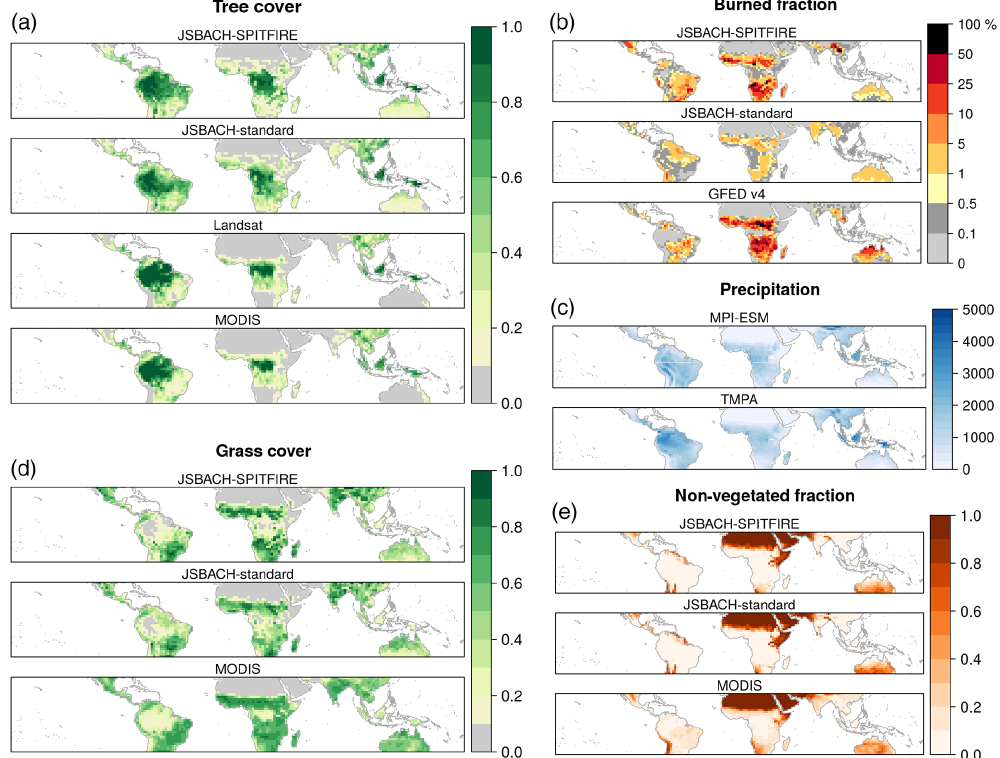
Figure 1. Spatial distribution of modelled and observed data sets used in this study. (a) Spatial distribution of tree cover fraction over the global tropics for the JSBACH-SPITFIRE and JSBACH-standard model simulation and the satellite data products from Landsat and MODIS. (b) Burned fraction (year − 1 ) as modelled by JSBACH-SPITFIRE and JSBACH-standard and the GFED v4 satellite product. (c) Precipitation inmmyear − 1 of the MPI-ESM and the TMPA data set. (d) Grass cover fraction and (e) non-vegetated fraction of the grid cell for the models and the MODIS satellite product. All data sets were remapped to 1.875 ◦ model resolution.